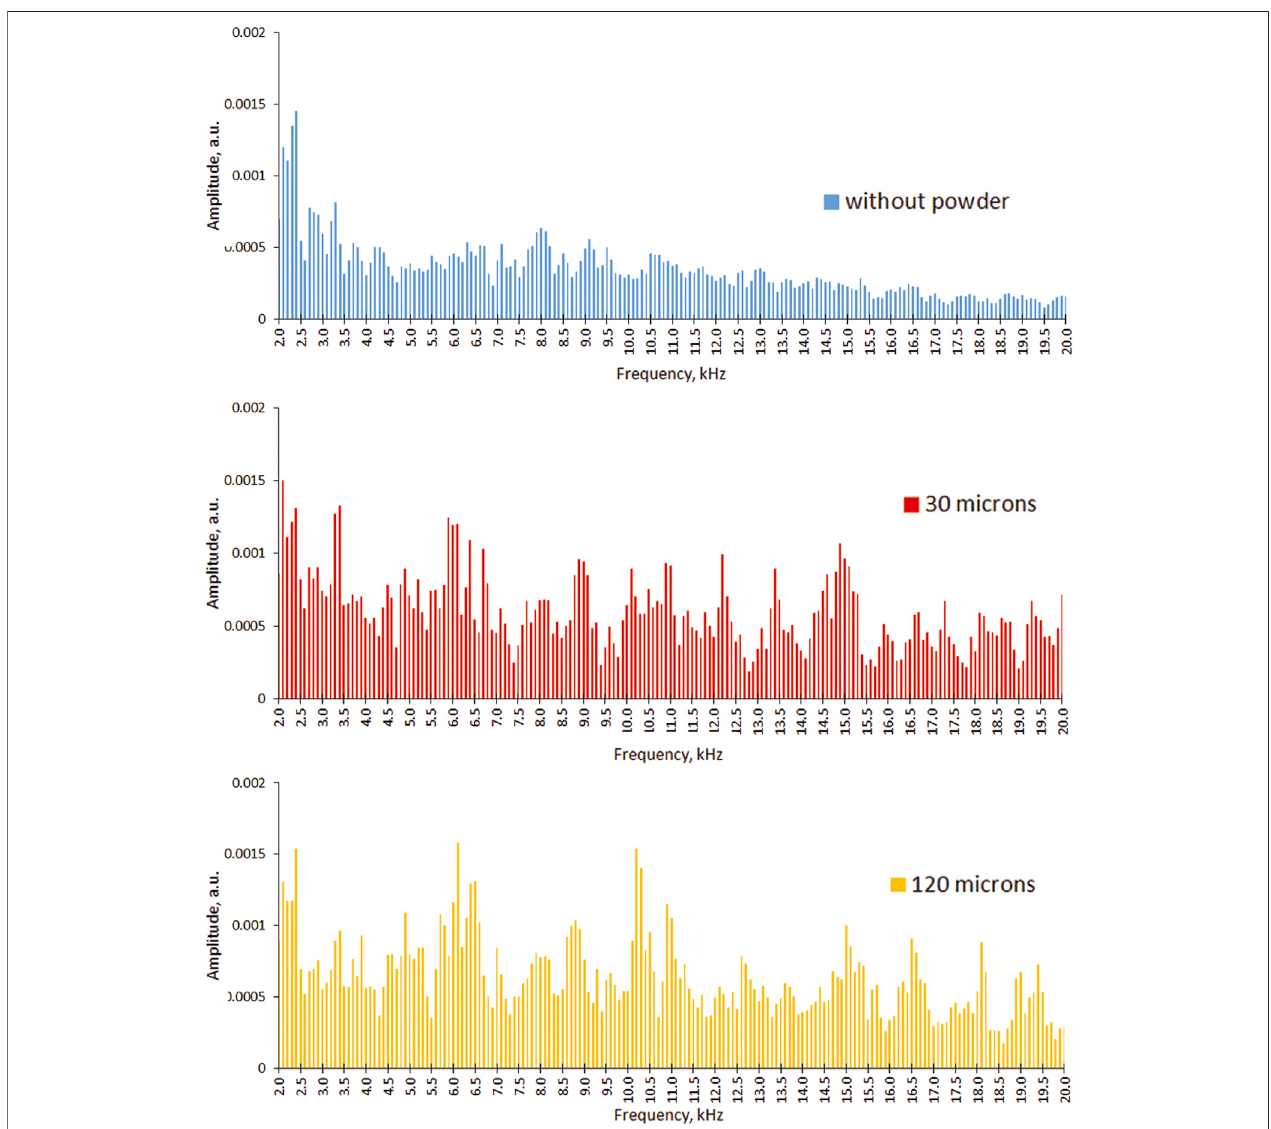
FIGURE 8 | FFT spectra and average intensity of AE signals for 10 single tracks produced without powder, 30 and 120 μ m powder layer thickness at 170 W laser power and 1.2 m/s scanning speed.